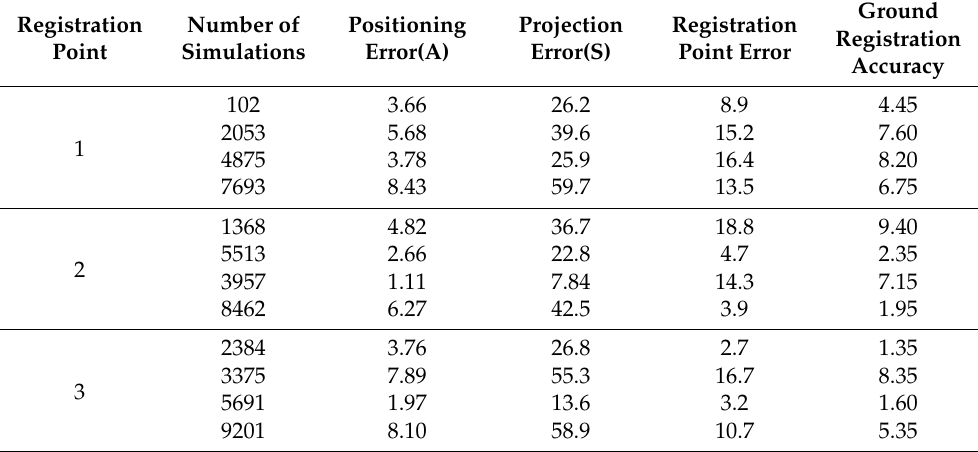
Table 4. Simulation